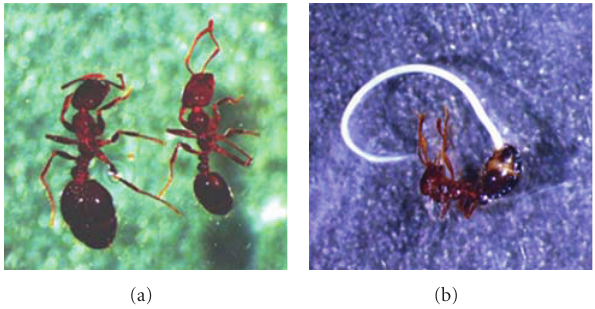
Figure 5: (a) Parasitized (left) and nonparasitized Solenopsis work- er. (b) Juvenile Allomermis solenopsi emerging from